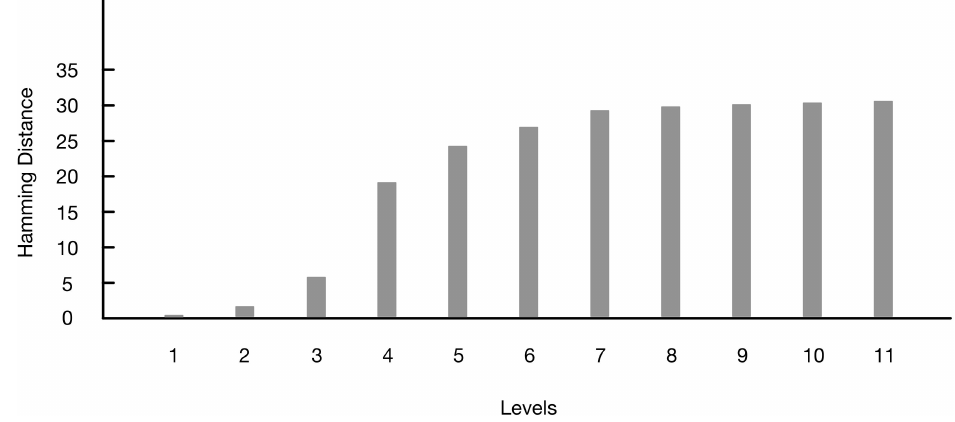
Figure 6. Hamming distance